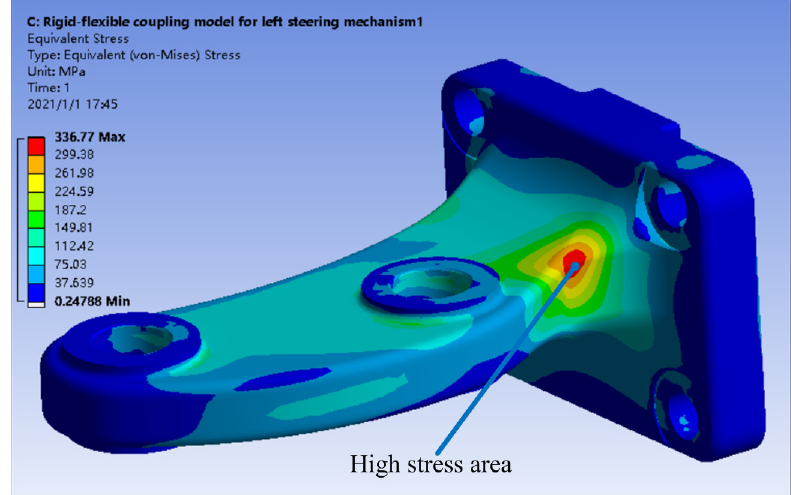
Figure 9. Von Mises stress distribution on the steering arm.